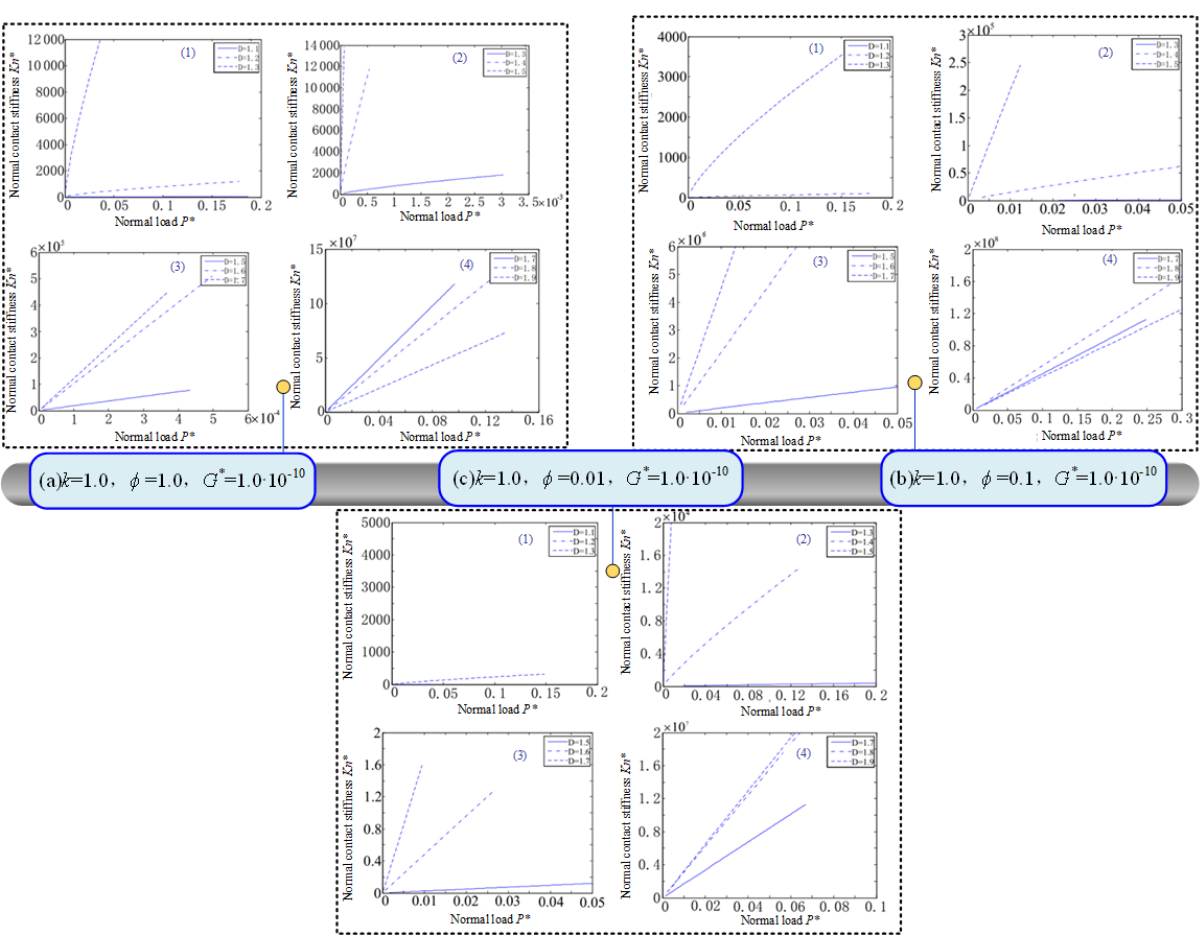
Figure 5. Effects of fractal dimension D on normal contact stiffness K ∗ n